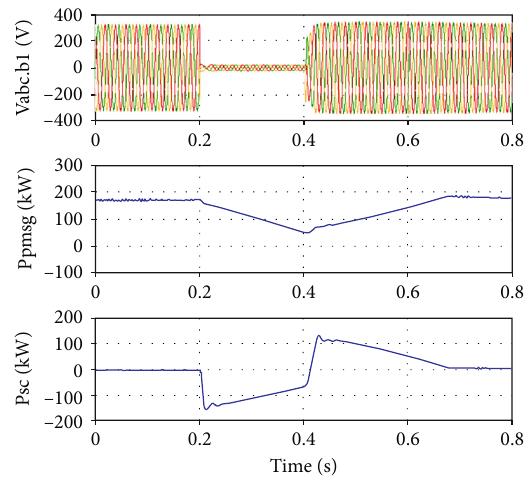
Figure 16: AC bus voltages, MTG power, and SC power during FRT.